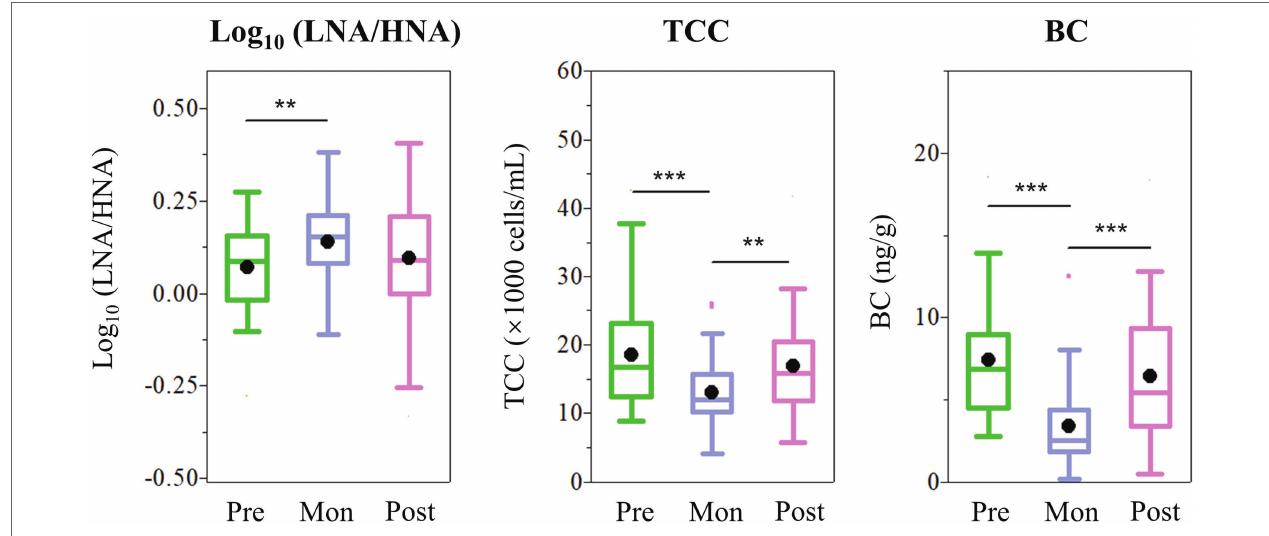
FIGURE 4 | Seasonal variation of Log 10 (LNA/HNA), TCC and BC concentration in ZQP. Correlation coefficient denoted as p < .05 ( * ), p < .01 ( ** ), and p < .001 ( ***